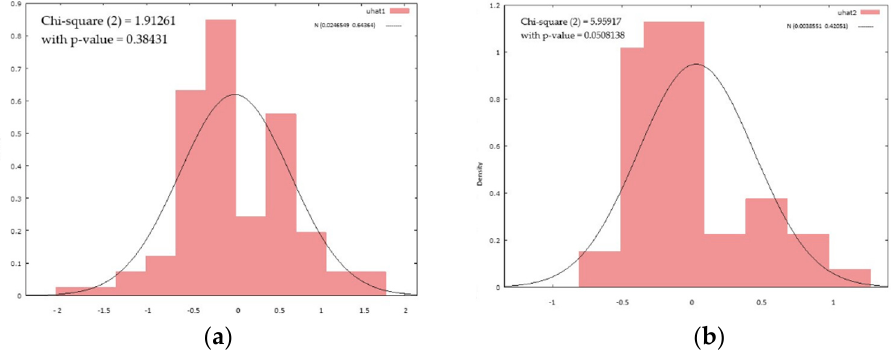
Figure 1. Histograms of Pearson model correlation of cognitive status in the ( a ) active group and ( b ) control group, showing a median Pearson correlation between the regression variables and dependent variables in the control group and a high dependence for some comorbidities (especially cardiovascular) and functional status in the cognitively impaired subgroup.